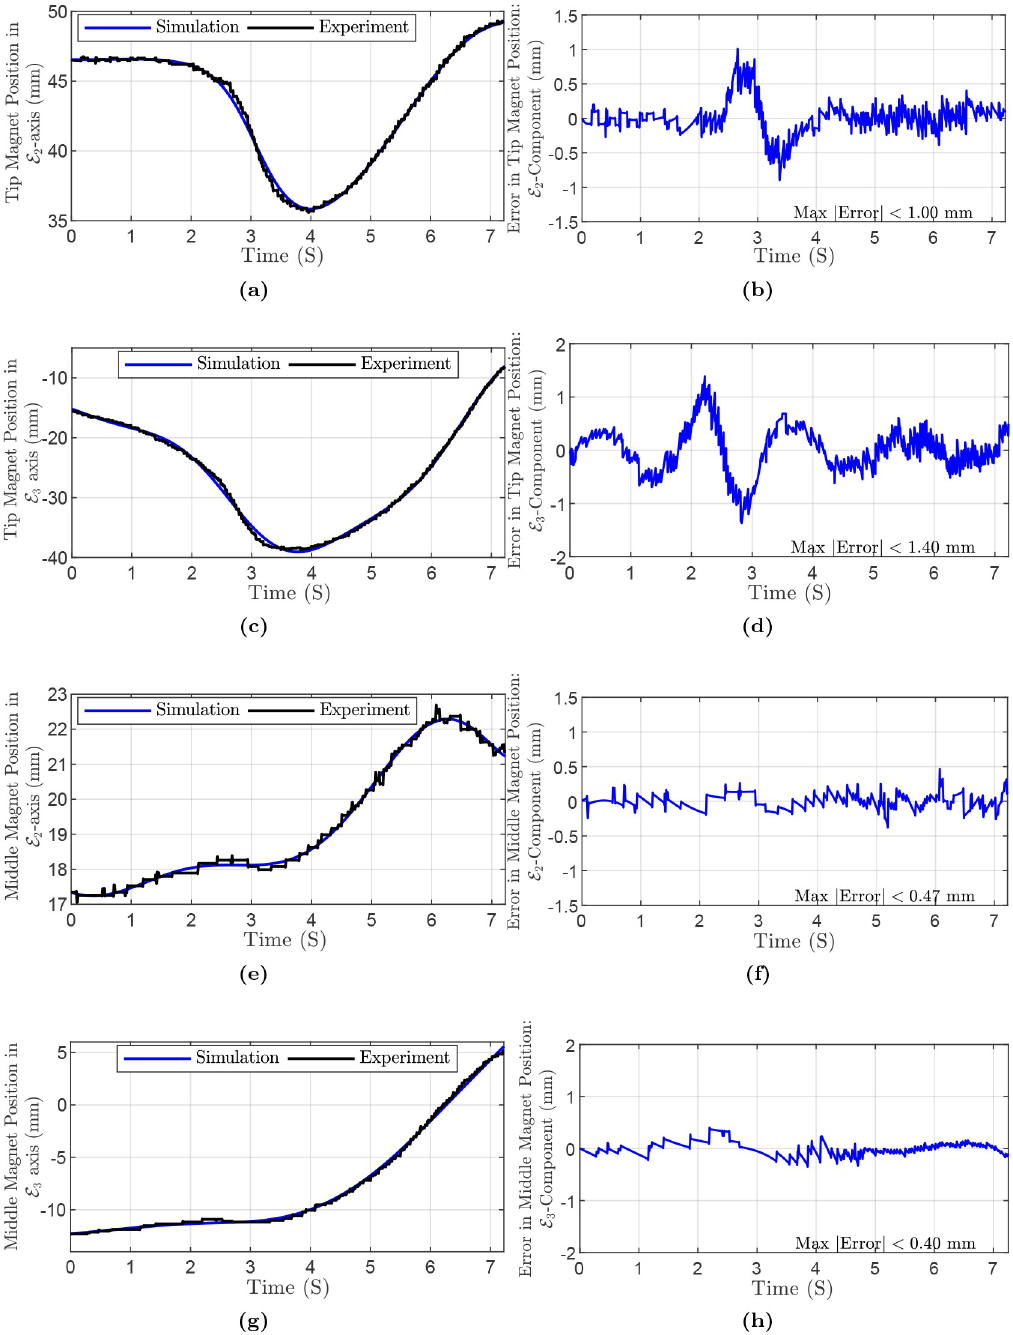
Fig 15. Simulation and experiment results of Polydimethylsiloxane (PDMS) rod with two embedded magnets, 2D experiment: (a) Tip magnet’s position in E -axis direction. (b) Error of tip magnet’s position in E -axis direction. (c) Tip magnet’s position 2 2 in E -axis direction. (d) Error of tip magnet’s position in E -axis direction. (e) Middle magnet’s position in E -axis direction. (f) 3 3 2 Error of middle magnet’s position in E -axis direction. (g) Middle magnet’s position in E -axis direction. (h) Error of middle 2 3 magnet’s position in E -axis direction. 3